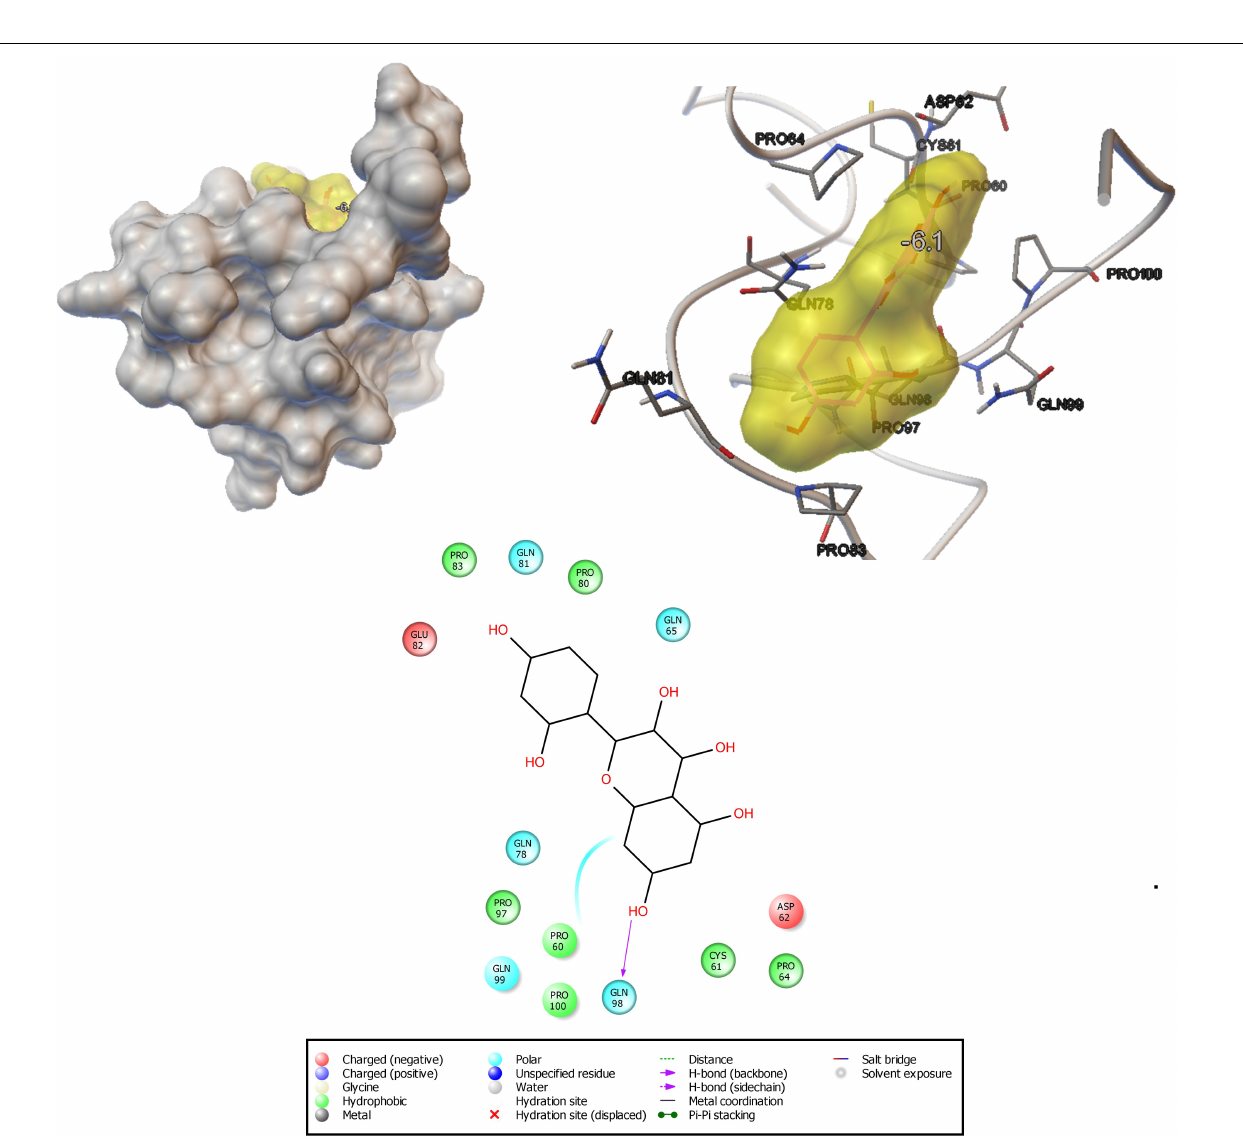
FIGURE 8 | Docking analysis shows the binding pattern and amino acid interactions of morin ( − 6.1 kcal/mol) with Hwp1 receptor in C. albicans for possible inhibition of adhesion as well as biofilm